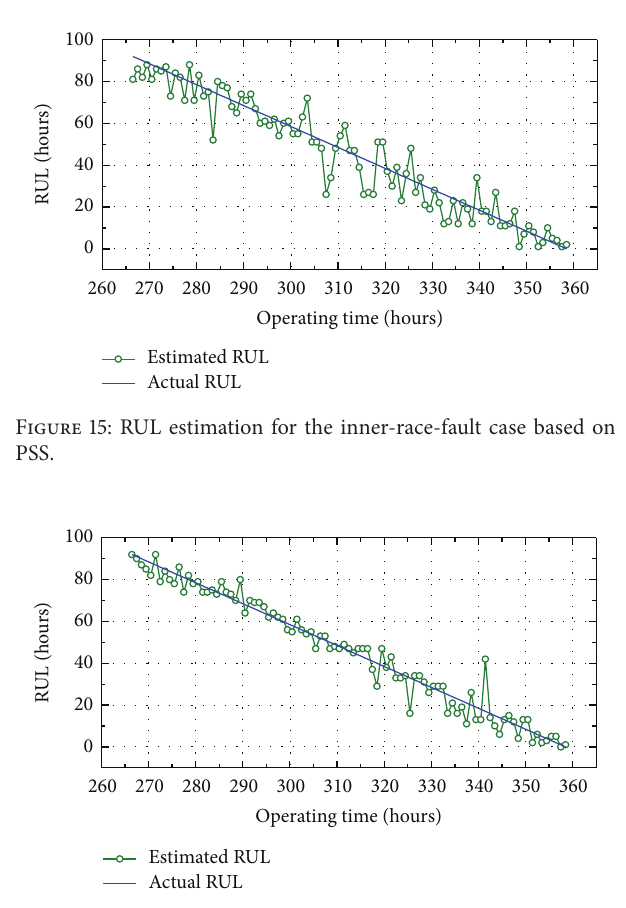
Figure 14: RUL estimation for the outer-race-fault case based on PSS.